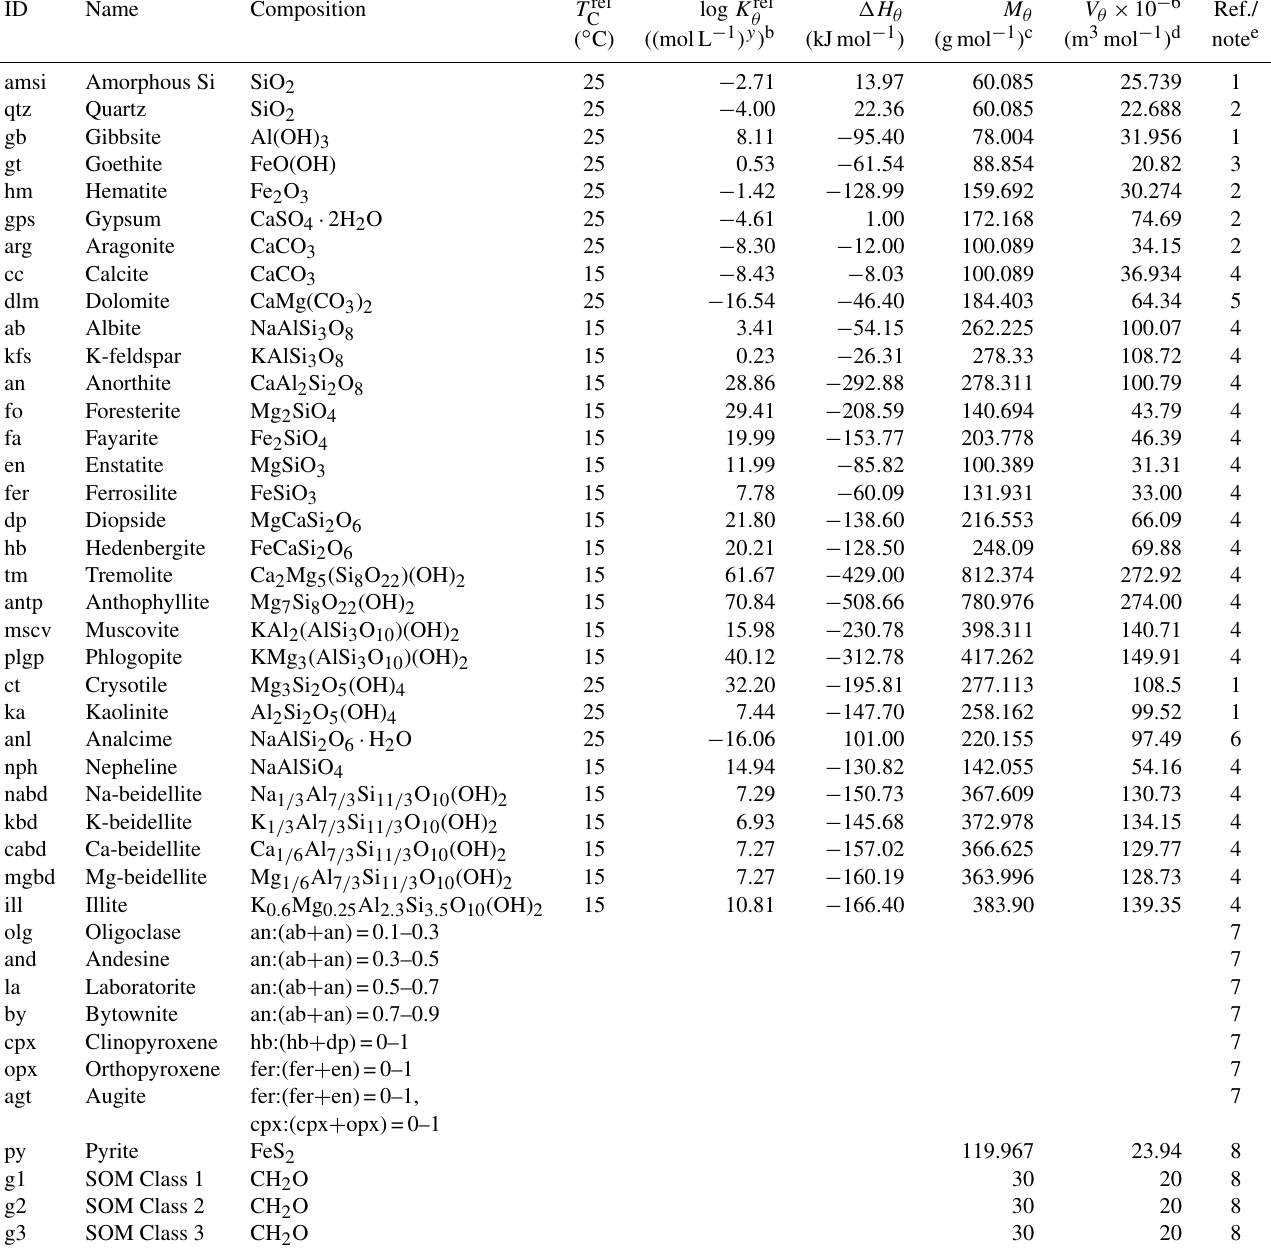
Table 1. Thermodynamic data of solid species a